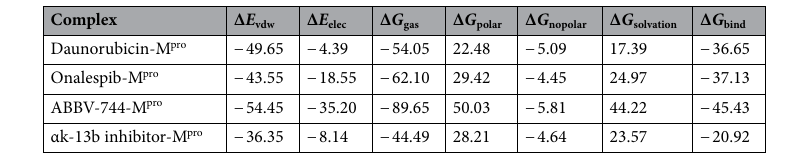
Table 3. Binding free energies and its components for the three hit compounds:M pro and αk-13b inhibitor:M pro using MM-GBSA method. The energy components are in kcal mol −1 .